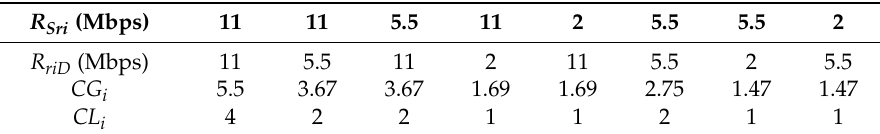
Table 2. FC-MAC scenarios in IEEE 802.11b (R SD = 1